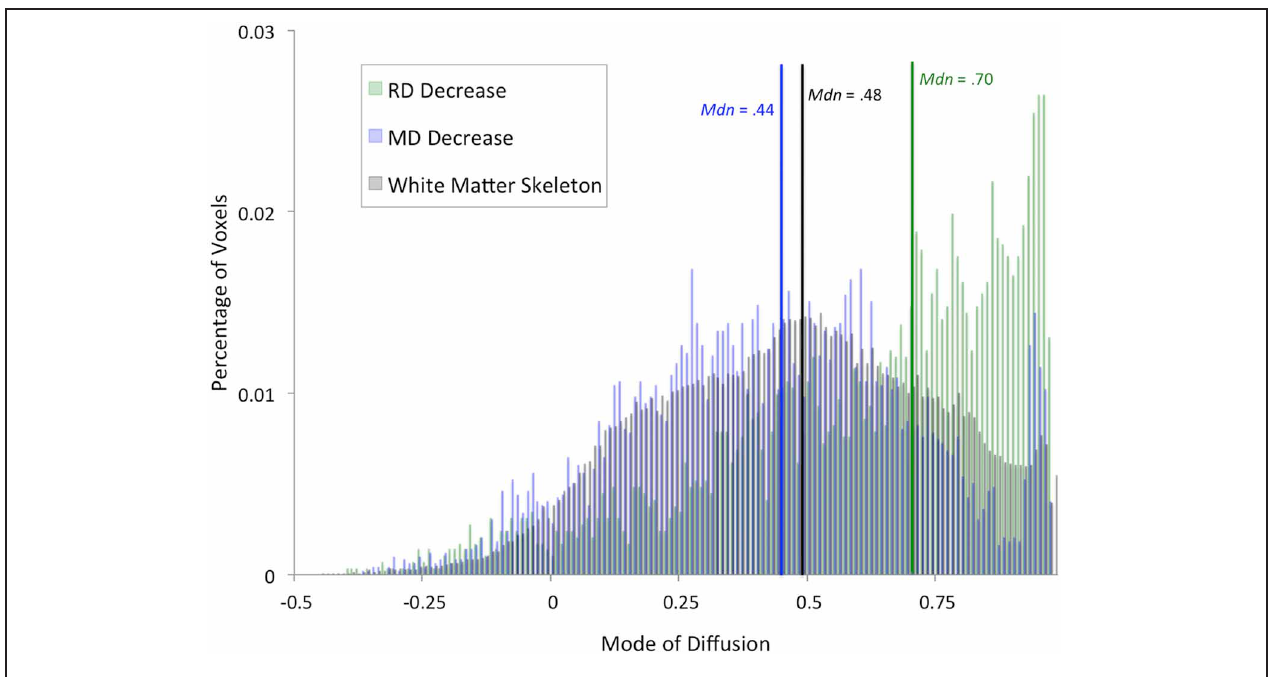
For comparison, a histogram of mode values for the entire white matter skeleton is shown (black). Median mode for each set of voxels is marked by a vertical line (RD: green, MD: blue, white matter skeleton: black).